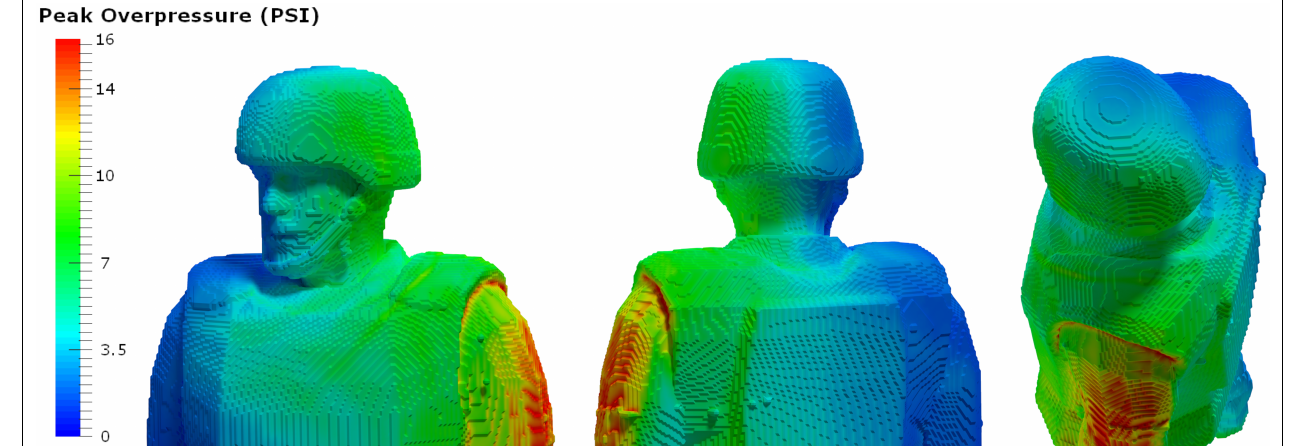
case, blast loads on the left side of the head exceed the threshold for tympanic membrane rupture, while the loads on the rights side do not (Wiri S, Needham C Reconstruction of IED blast loading to personnel in the open. Twenty-first International Shock Interaction Symposium, International Shock Wave Institute, 3–8, August, 2014, Riga,